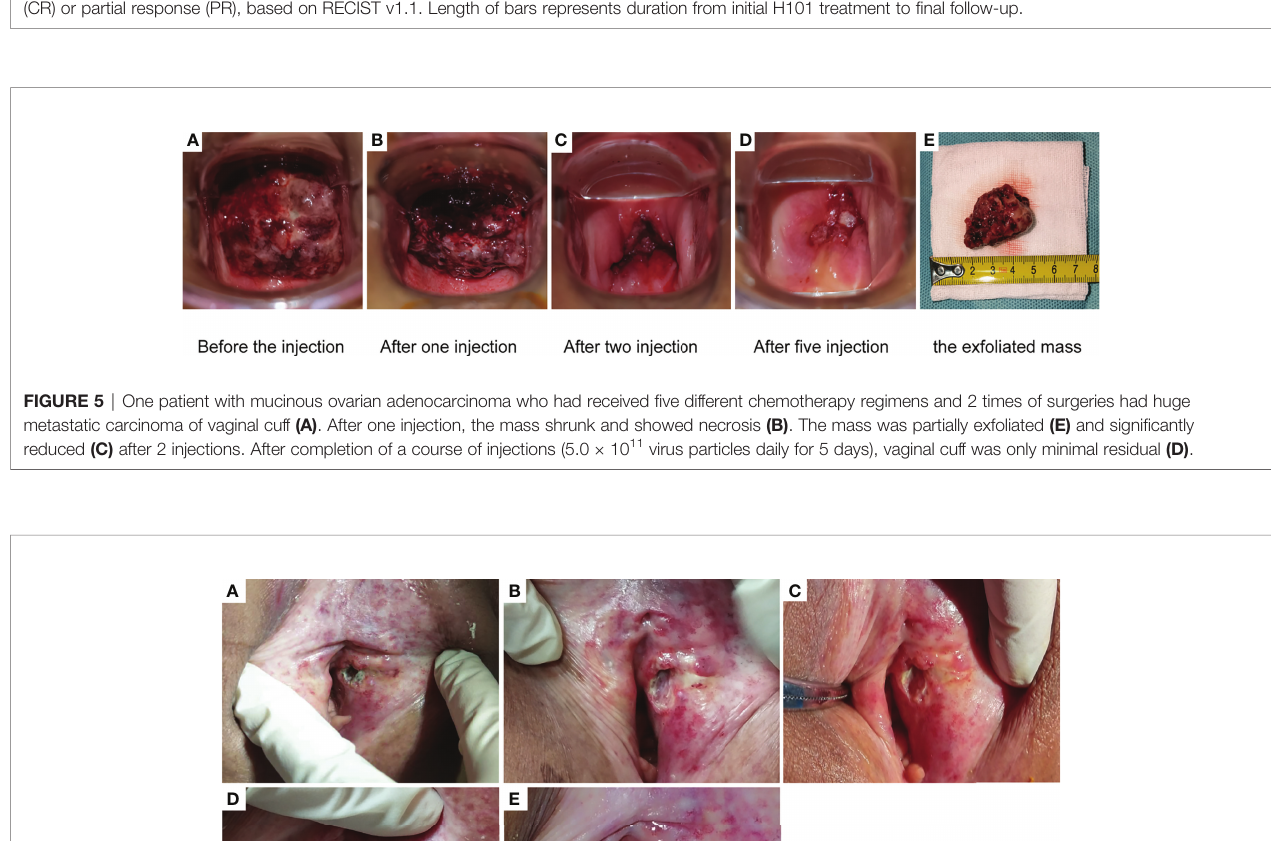
FIGURE 4 | Swimmer plot representing critical points and duration of response (DOR) during treatment and follow-up, in patients who achieved complete response (CR) or partial response (PR), based on RECIST v1.1. Length of bars represents duration from initial H101 treatment to fi nal follow-up.